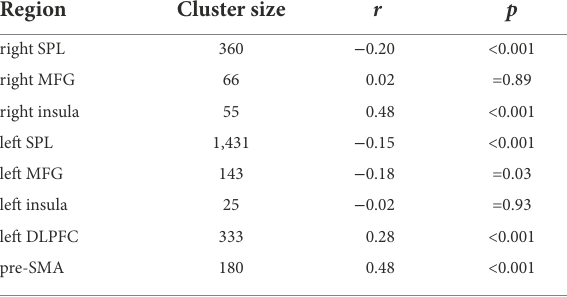
TABLE 2 Neural representational similarity in overlapping